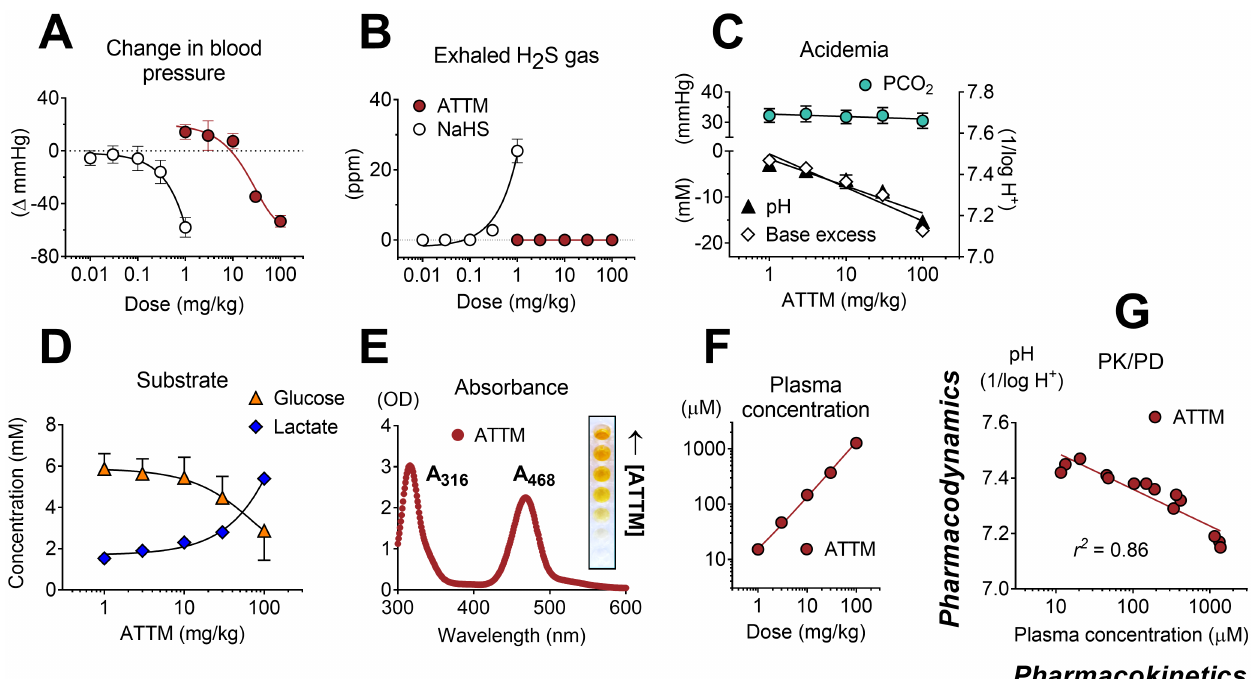
Fig 3. Pharmacokinetic/pharmacodynamic studies. Maximal changesin mean arterial blood pressure (A) and detectionof (peak) exhaled H 2 S gas (in parts per million [ppm]) (B) followingincreasingIV bolus doses of ammoniumtetrathiomolybdate(ATTM) or NaHS. No exhaledH 2 S was detectablefollowingATTM administration. Acid/baseinteractionsfollowingATTM treatment are shown in (C); the top left y -axis denotes (arterial)partial pressure of carbondioxide(PCO 2 ); bottom left and right y -axes are (arterial)base excess and pH, respectively.Alterationsin (arterial)glucoseand lactate followingATTM treatment are shown in (D). (E) shows the absorbance (ultra violet—visible) spectrum of ATTM with (inset) a row of microplatewells used to construct a standard curve. (F) and (G) respectivelyshow changesin ATTM plasma levels (measured using the absorbance peak at 468 nm at 2 min after ATTM administration) againstthe quantity of drug administered and subsequent (25 min later) changesin arterial pH. n =